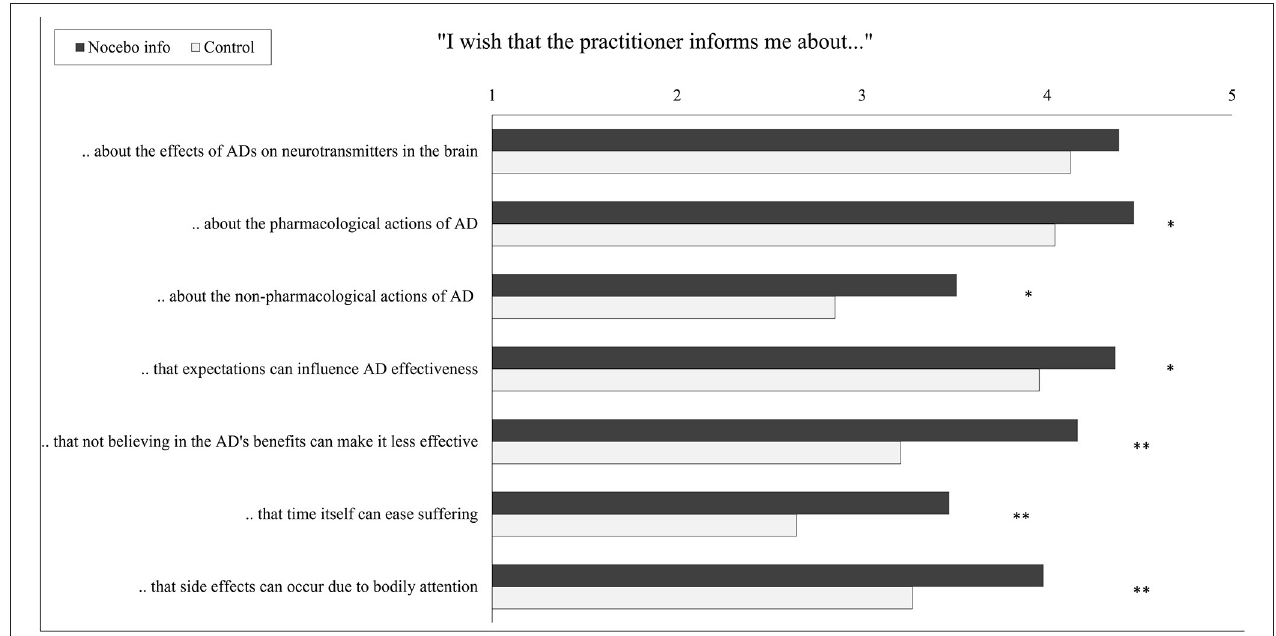
FIGURE 4 | Wish for disclosure about modes of action of the antidepressant by the intervention group. Student’s t -tests for independent samples were conducted. Each scale ranges from 1 “do not agree at all” to 5 “fully agree”; bars indicate means. AD, antidepressant, * p < 0.05, ** p < 0.01.